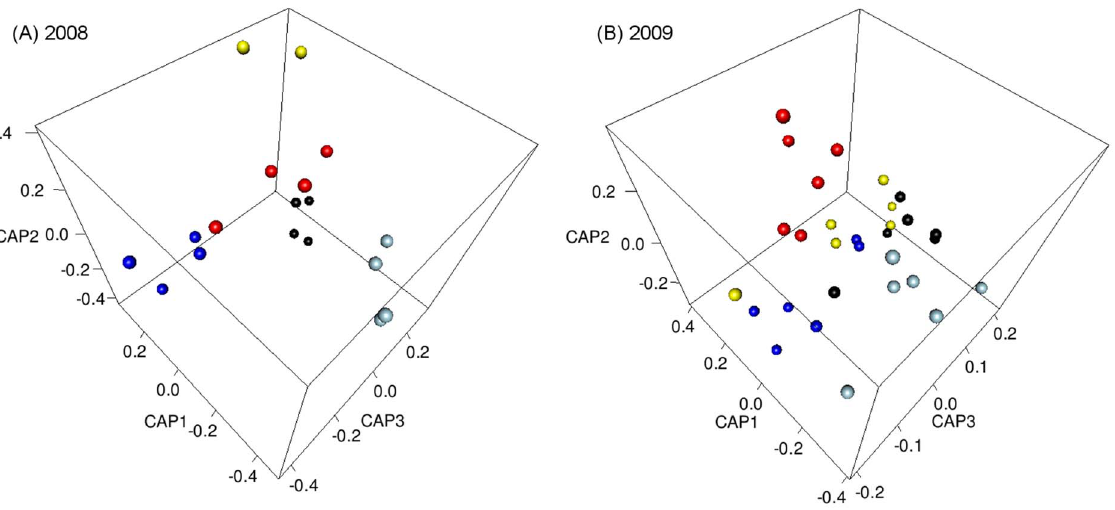
Figure 2. The geographical resolution achieved between the experimental regions using multiple biogeochemical markers. Canonical analysis of principle co-ordinates plots of d 2 H, trace element concentration (ng/g) and 206 Pb/ 208 Pb, 207 Pb/ 208 Pb data from H. armigera adult specimens, reared from Australian and New Zealand sites: (A) March – May 2008 and (B) Jan – March 2009. The 2009 moth data was optimised to remove non-informative variables and also includes 87 Sr/ 86 Sr values. Black = MC, yellow = BP, dark blue = AK, light blue = NSW, red = QLD.